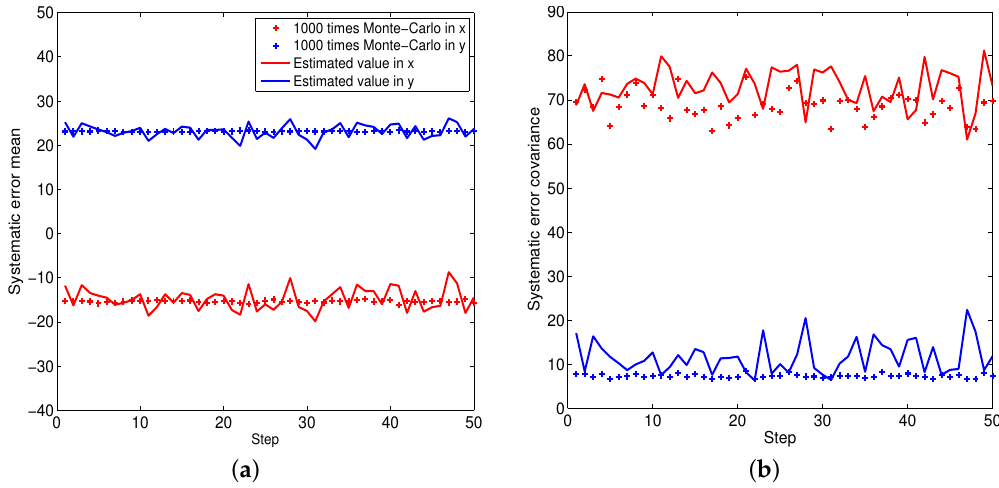
Figure 2. The statistic properties of the systematic error for object one. ( a ) Mean of systematic error; ( b ) Covariance of systematic